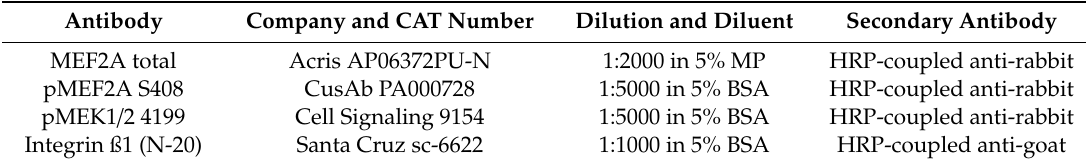
Table 2. Summary of antibodies used in this study with corresponding dilution and host. Antibody Company and CAT Number Dilution and Diluent Secondary